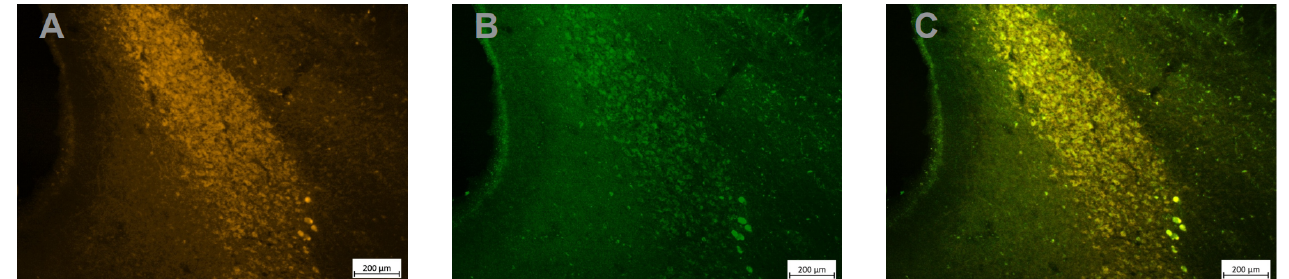
Figure 5. Strong DREADD expression in TH+ LC neurons. Adjacent sections treated with an anti- TH antibody ( A ), an anti GFP antibody to reveal the HM4Di-CFP DREADD ( B ) and an overlay of the 2 images ( C ) shows the perfect overlap between TH expression and DREADD expression in LC neurons.